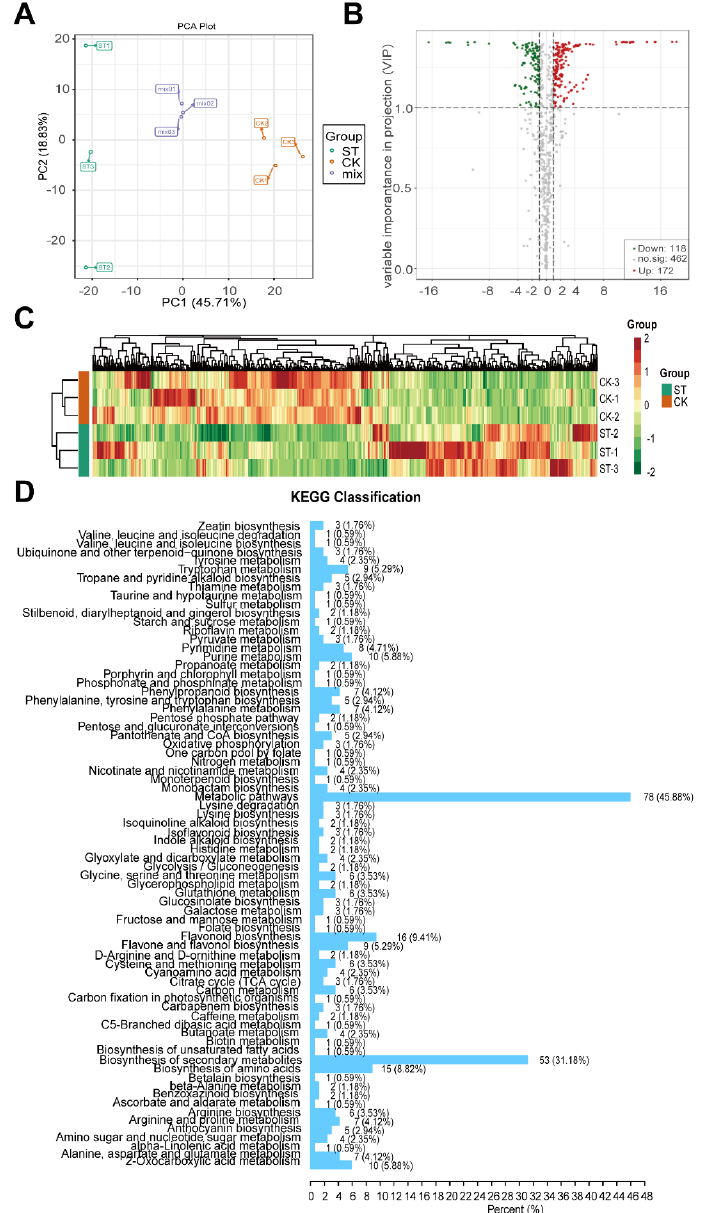
Figure 6. Differentially abundant metabolites induced by low light treatments in the petiole of XH1 cai-tai seedlings. ( A ) Principal component analysis across samples. ( B ) Volcano plot representing the differentially abundant metabolites (DAMs). ( C ) Heatmap showing DAM induced by low light treatments. ( D ) KEGG analysis on DAMs induced by low light treatments. The responses of sucrose metabolism and citrate acid cycle pathways to low light in XH1 cai-tai seedling were further analyzed based on the metabolism analysis. Results show that eight metabolites related to sucrose metabolism and tricarboxylic acid cycle (TCA) cycle were downregulated by low light, with the log2(fold changes) ranged from -